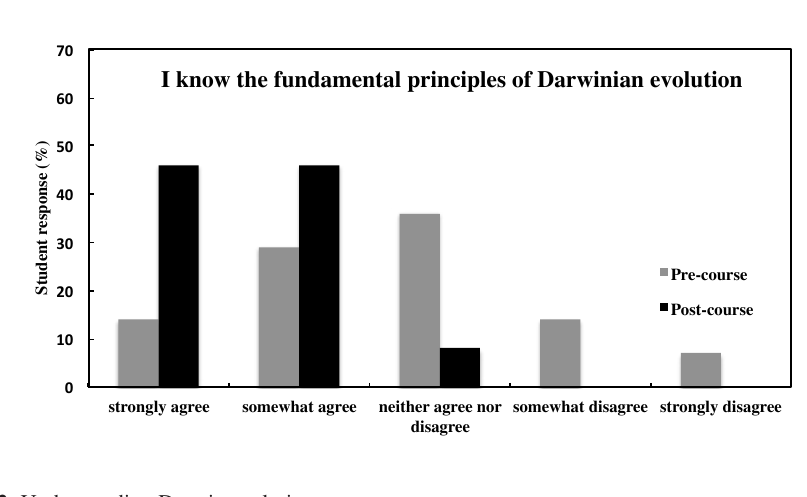
Figure 2. Understanding Darwin evolution.